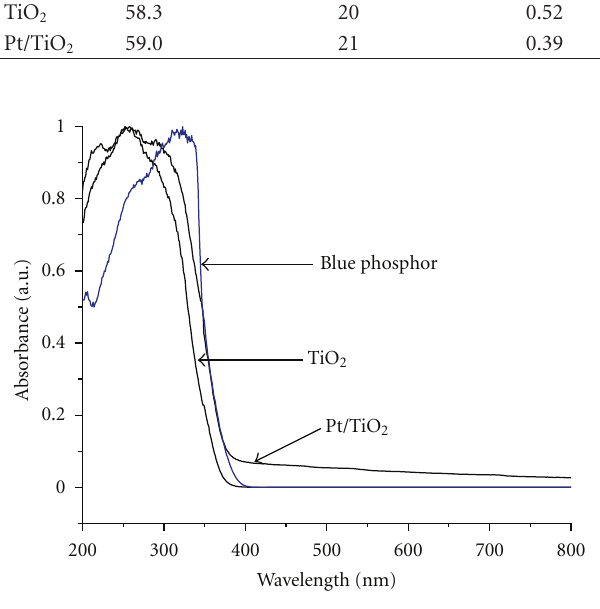
Figure 3: UV-Vis DRS spectra for TiO 2 and Pt/TiO 2 photocatalysts compared with phosphors emission.